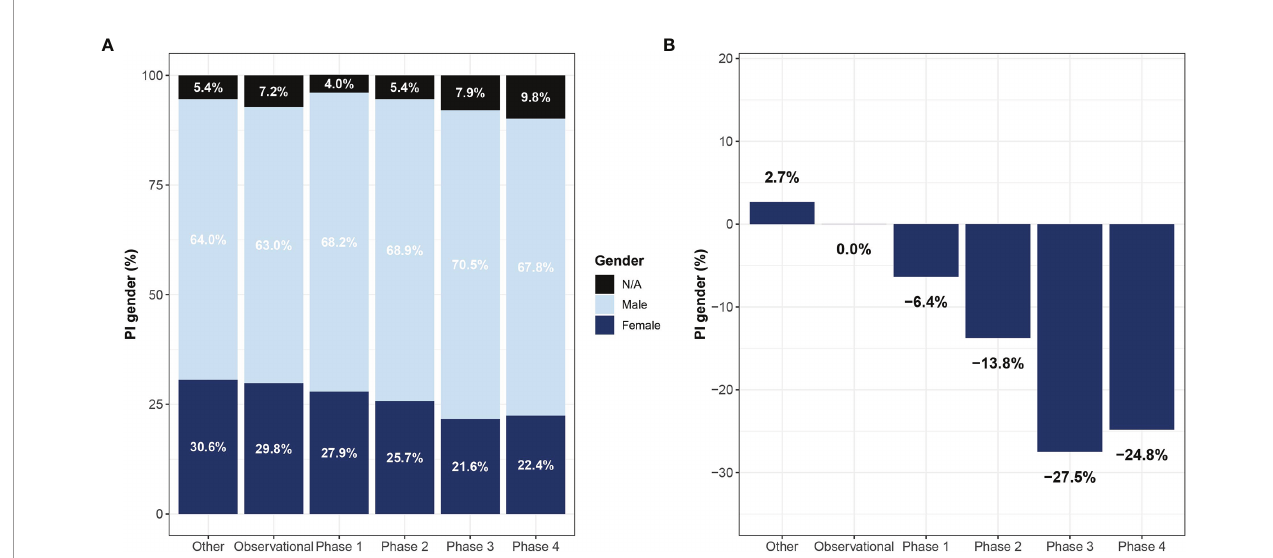
FIGURE 3 | Representation of women lead investigators in oncology clinical trials by study type. Shown are gender proportions of principal investigators leading trials of different study phases (A) and the reduction in proportions relative to observational studies (B) . Names with low gender prediction score or names who which gender could not be determined are marked as not applicable (NA).